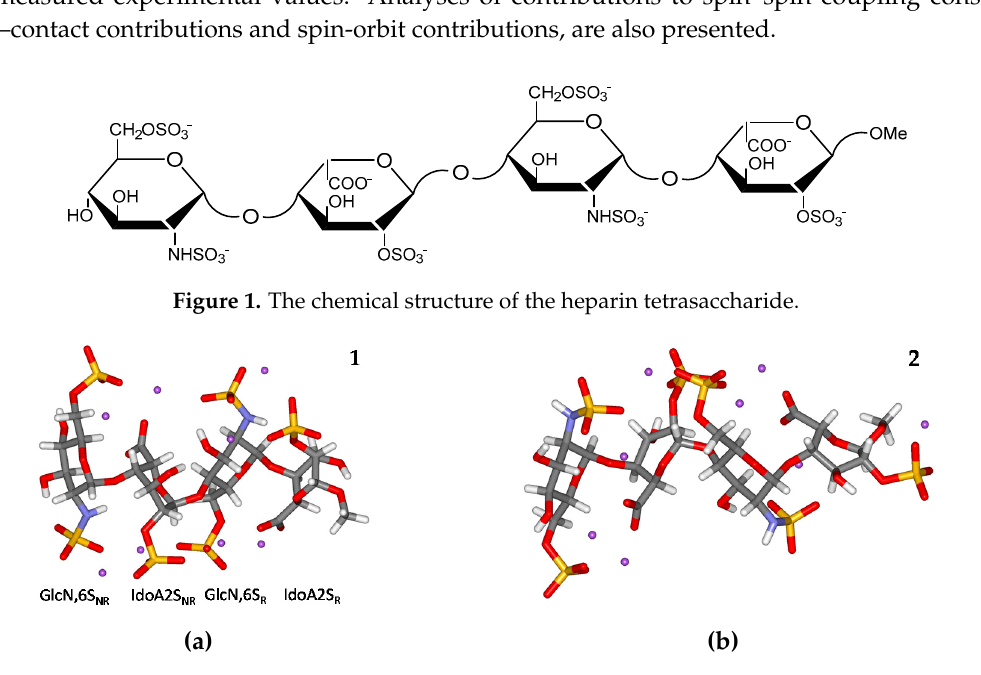
Figure 2. The density functional theory (DFT)–optimised structure of the heparin tetrasaccharide. The two forms, 1 and 2 , have different conformations of the IdoA2S residue. The IdoA2S residues are in the 1 C 4 conformation in ( a ) and in the 2 S 0 conformation in ( b ). The GlcNS,6S residues are in the 4 C 1 conformation. Violet dots represent sodium ions. Solvent (water) molecules are not shown for clarity.